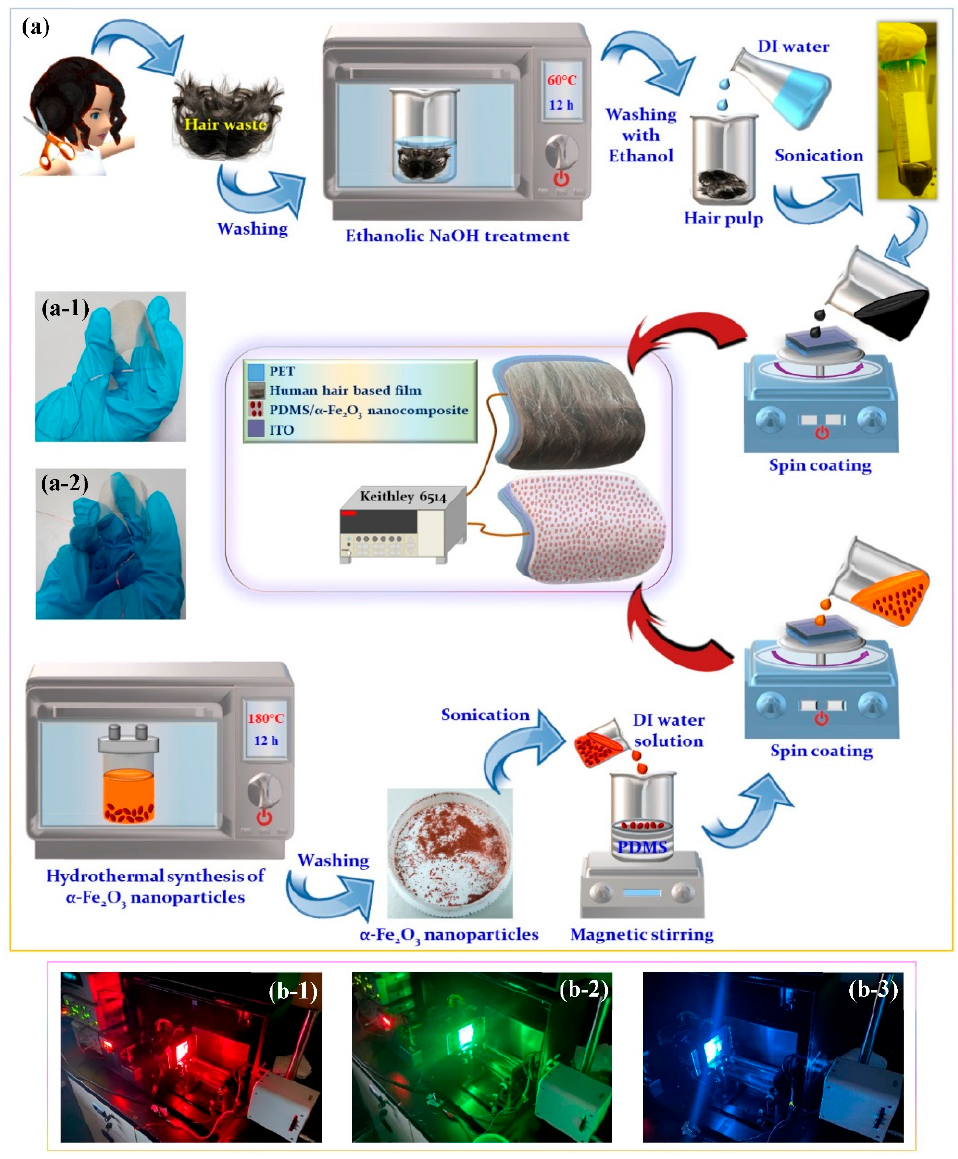
Figure 1. ( a ) Schematic demonstration of the fabrication procedure for triboelectric nanogenerator (TENG) consists of PDMS/ α -Fe 2 O 3 nanocomposite film (as the negative tribo-layer) and processed hair film (as the positive tribo-layer) along with the respective photographs of the ( a-1 ) positive and ( a-2 ) negative tribo-layers. ( b-1 – b-3 ) The photographs of the fabricated TENG measurement arrangement under illumination with different wavelengths.